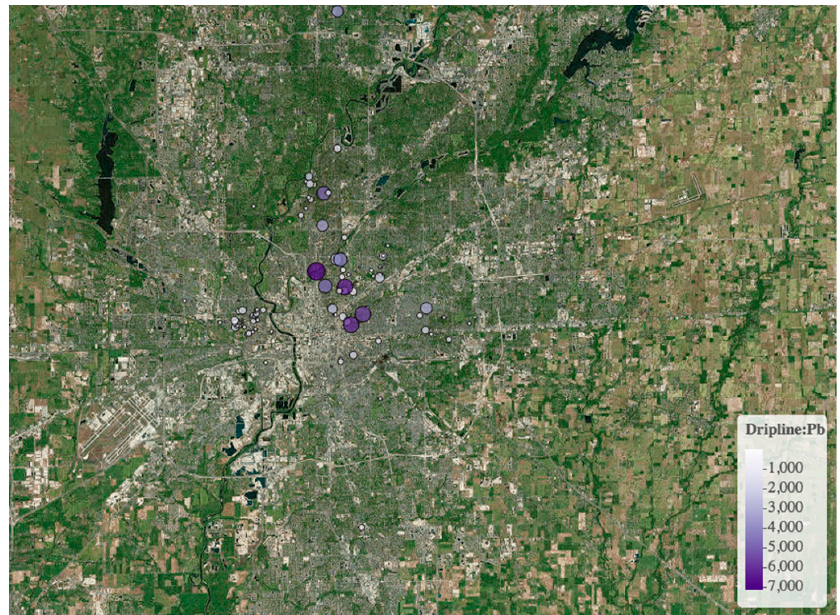
Figure 2. Example sample location map for Pb concentrations in dripline soils from Indianapolis, Indiana (USA), displayed as output from an application under development to assist citizen scientists in understanding the distribution patterns of metals in the city. Note that this represents roughly 500 individual properties, with multiple locations “hidden” under circles with high soil Pb concentrations.